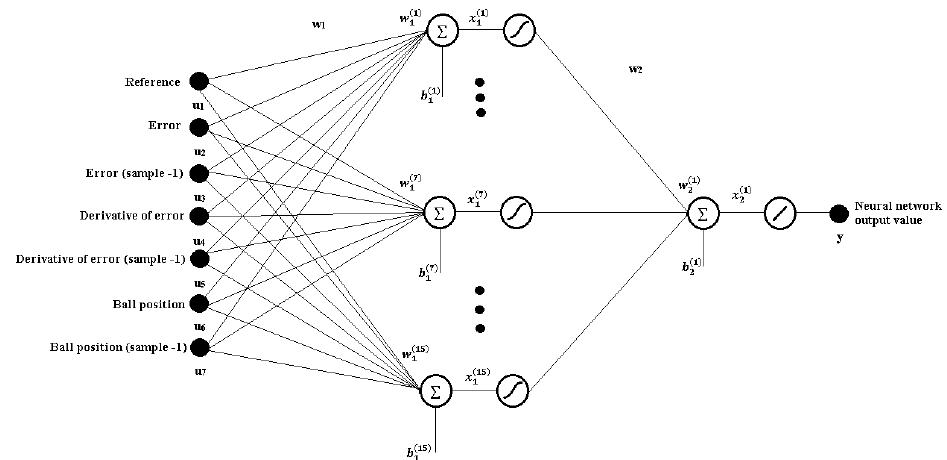
Figure 10. The structure of the original neural